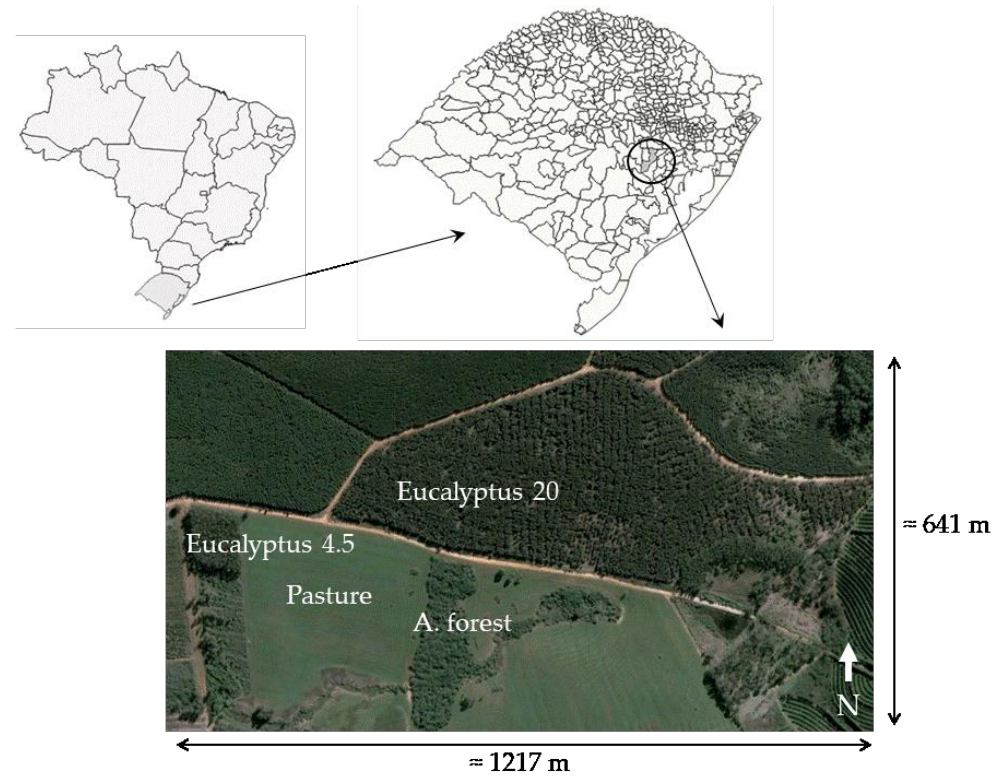
Figure 1. Map of Brazil, with Rio Grande do Sul State shown as hatched; map of Rio Grande do Sul State with Butiá shown as hatched; and image from Google Earth with the land uses studied. Image of Google Earth dated 5 September 2005.